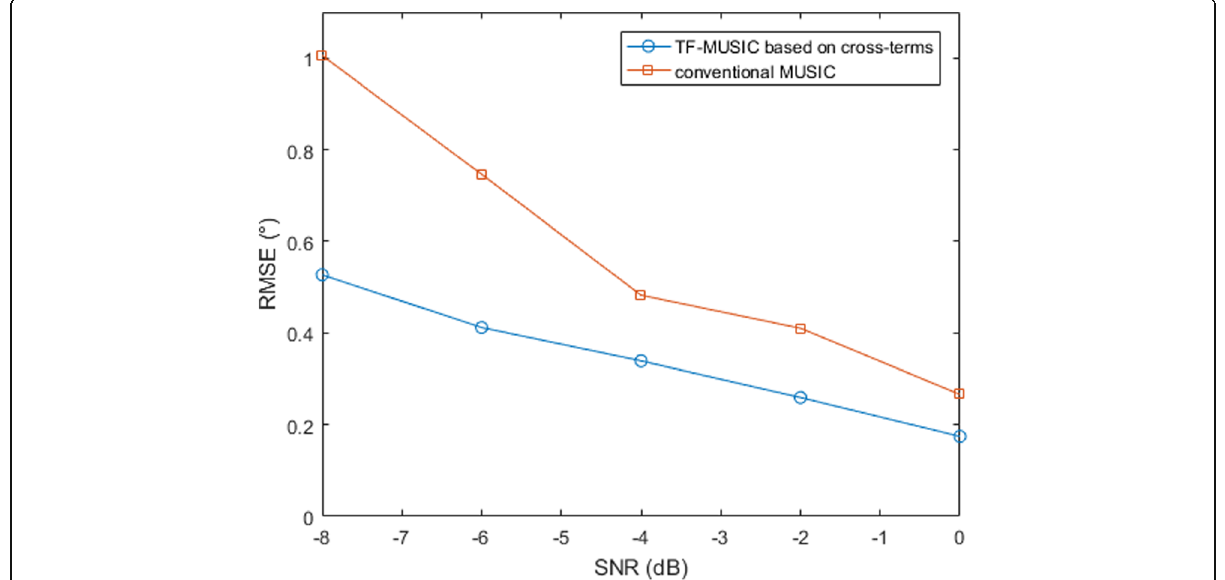
Fig. 7 The RMSE of DOA estimation versus input SNR of weak